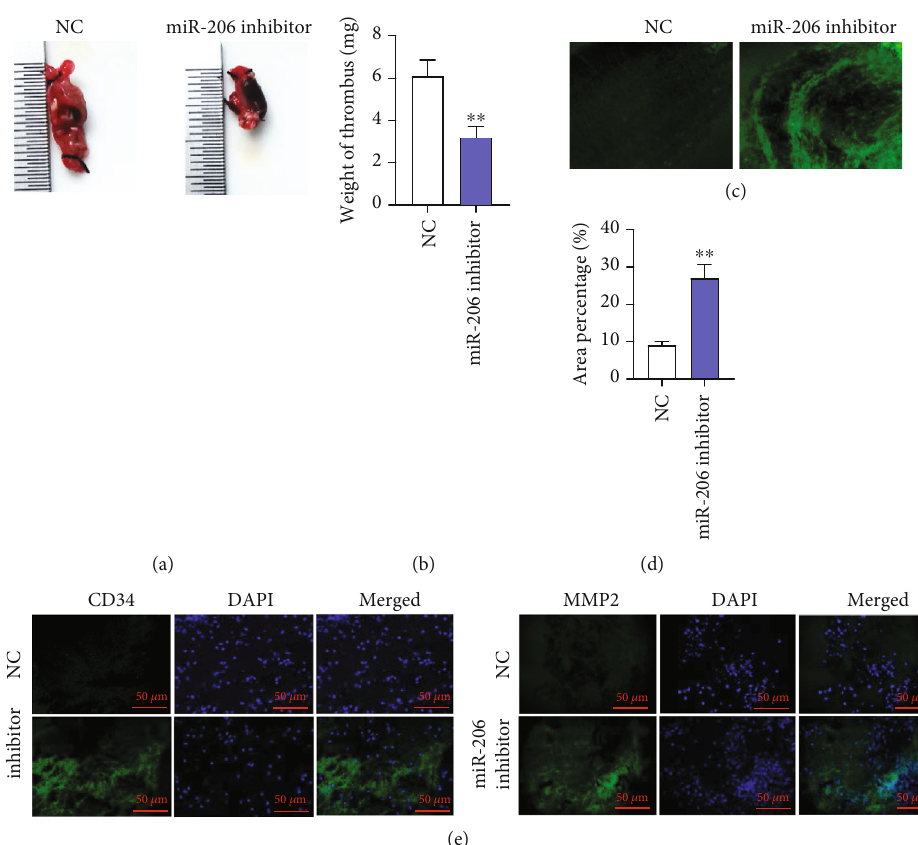
Figure 6: miR-206 knockdown enhances EPC homing ability and facilitates thrombus recanalization and resolution in mice with DVT. (a, b) DVT mouse models were injected with GFP-NC inhibitor-EPCs or GFP-miR-206 inhibitor-EPCs. Size and weight of thrombus at day 7 after the injection. (c, d) The homing ability of EPCs to the thrombosis site at day 7 after the injection was evaluated by calculating the percentage of green- fl uorescent area. (e) The expression of CD34 (red) and MMP2 (red) in thrombus was detected by immuno fl uorescence. n = 10 in each group. ∗∗ p < 0 : 01